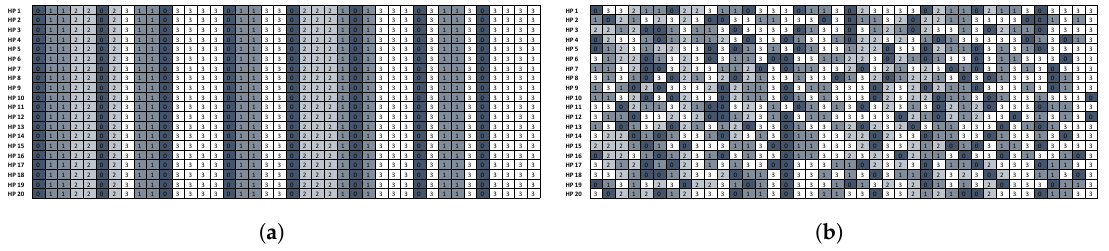
Figure 8. Examples of the schedule randomization protocol with three tasks: ( a ) vanilla fixed priority scheduling (e.g., schedules without randomization); and ( b ) TaskShuffler (fine-grained scheduling with randomizing idle times). Blocks numbered 0–2 are the execution of periodic tasks, while blocks numbered 3 indicate idle time (i.e., the idle task). The following taskset parameters are used in the illustration: τ 0 ( 5,1,5 ) , τ 1 ( 8,2,8 ) , τ 2 ( 20,3,20 ) where each task τ i ( C i , T i , D i ) , 0 ≤ i ≤ 2 is